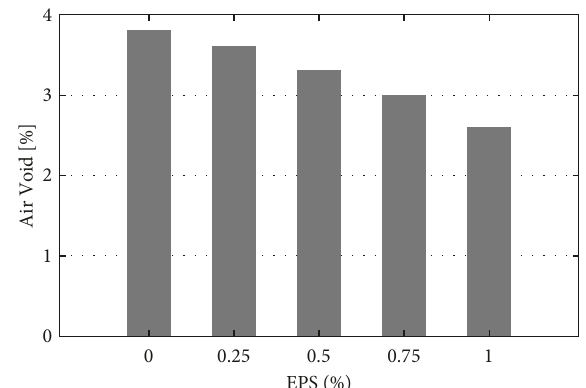
Figure 10: Relationship between VFA and EPS.